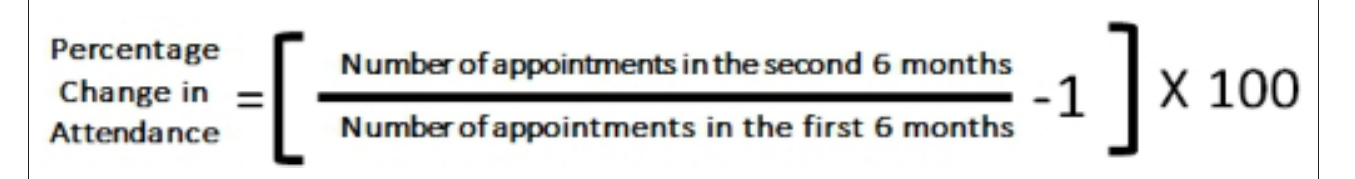
Figure 2 Calculation of percentage change in